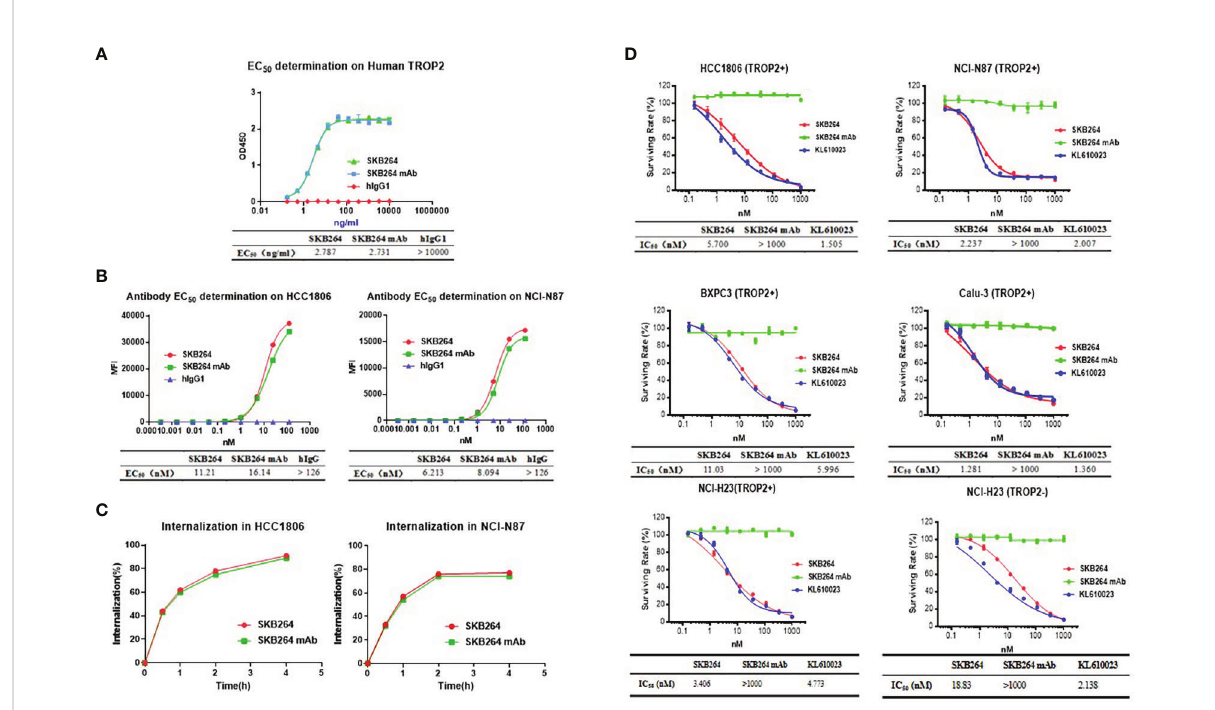
FIGURE 2 In vitro activities of SKB264. (A) Binding to human TROP2 estimated by ELISA (duplicates, mean ± SEM). (B) SKB264 binding to HCC1806 and NCI-N87 estimated by FACS. (C) Internalization of SKB264 or SKB264 mAb in HCC1806 and NCI-N87 cells. (D) In vitro cell growth inhibitory activity (triplicates, mean ± SEM) in HCC1806, NCI-N87, BxPC-3, Calu-3, NCI-H23 (TROP2+), and NCI-H23 (parental)